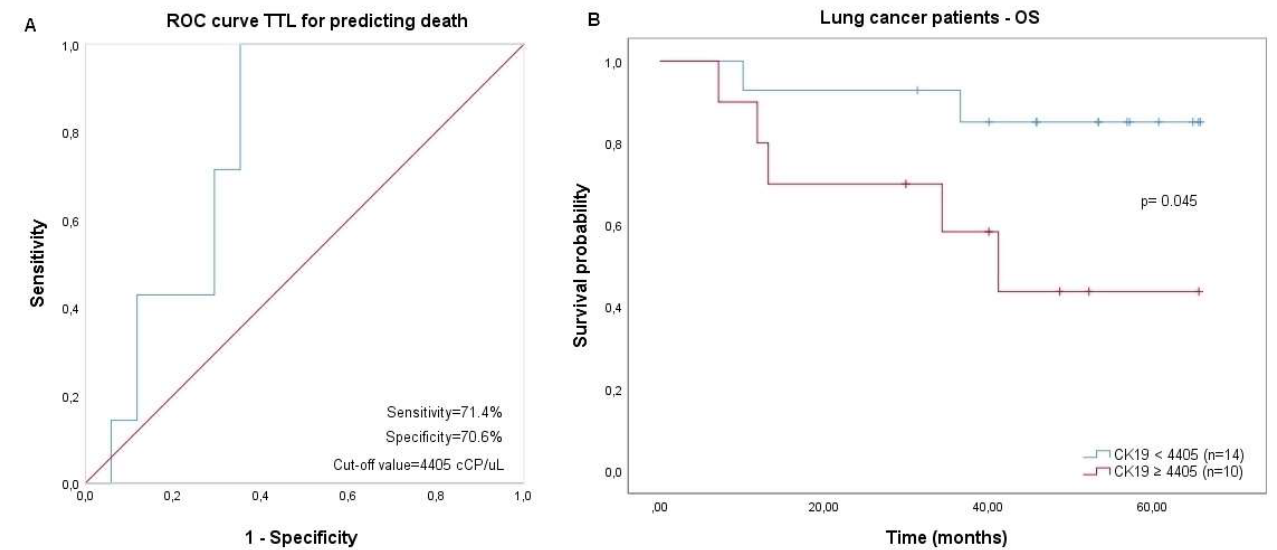
Figure 5. ROC curve for predicting death. AUC = 0.773 95% IC (0.588–0.959), p -value = 0.039 ( A ). OS curve for patients with high survival probability (<4405 cCP/uL) vs. patients with low survival probability ( ≥ 4405 cCP/uL) p -value = 0.045 ( B